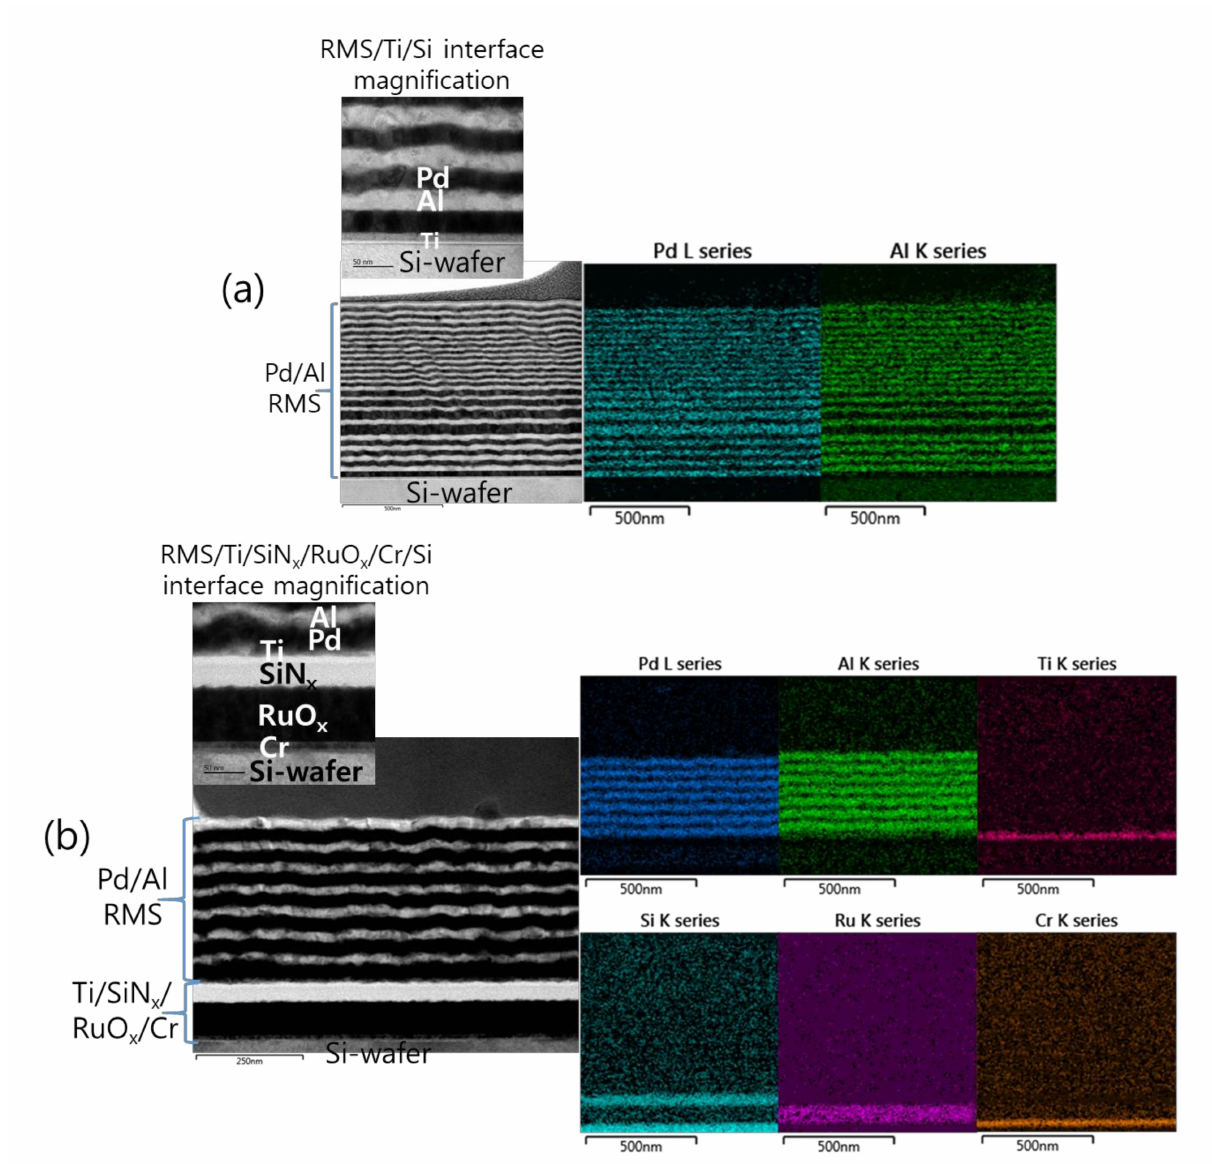
Figure 2. Transmission electron microscope (TEM) cross sections ( left ) and corresponding energy dispersive X-ray spectrom- eter (EDS) elemental mappings ( right ) of as-deposited Pd/Al RMS on the Ti/Si-wafer ( a ), and on the Ti/SiN x /RuO x /Cr/Si- wafer ( b